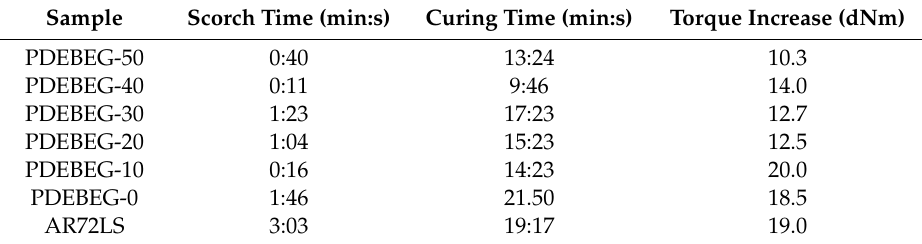
Table 5. Curing parameters for the PDEBEG / CB and AR72LS / CB elastomers.